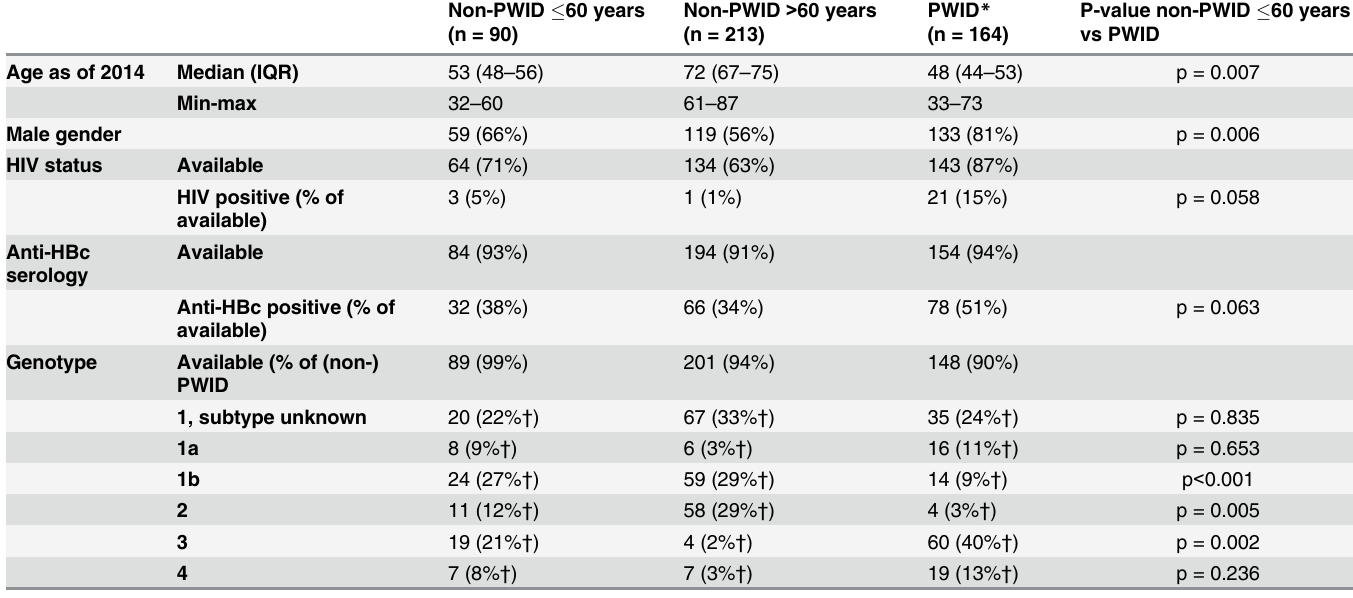
Table 3. Italian- and Spanish-born persons in the Swiss Hepatitis C Cohort Study: comparison of persons who do not inject drugs (non-PWID) (cid:3) 60 years and > 60 years versus persons who inject drugs (PWID) of all ages.